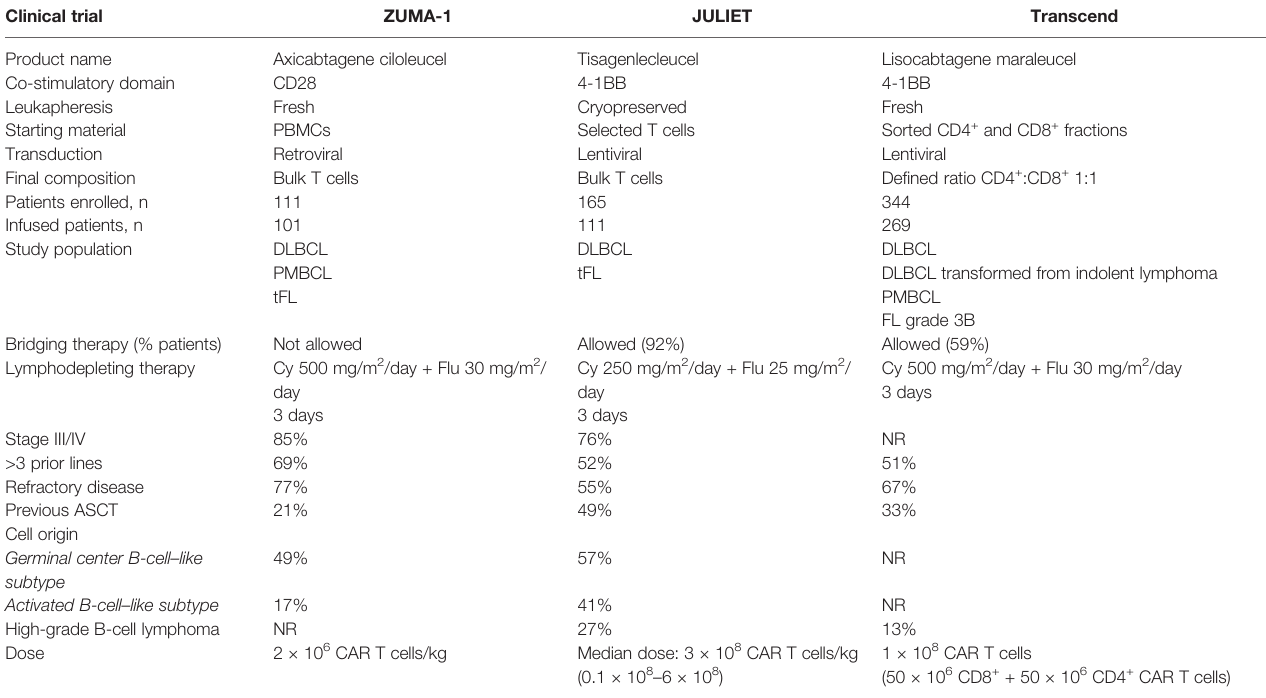
TABLE 1 | Pivotal Clinical Trials with CART19 Therapy for B-NHL: Comparison of Relevant Features Among Studies. Clinical